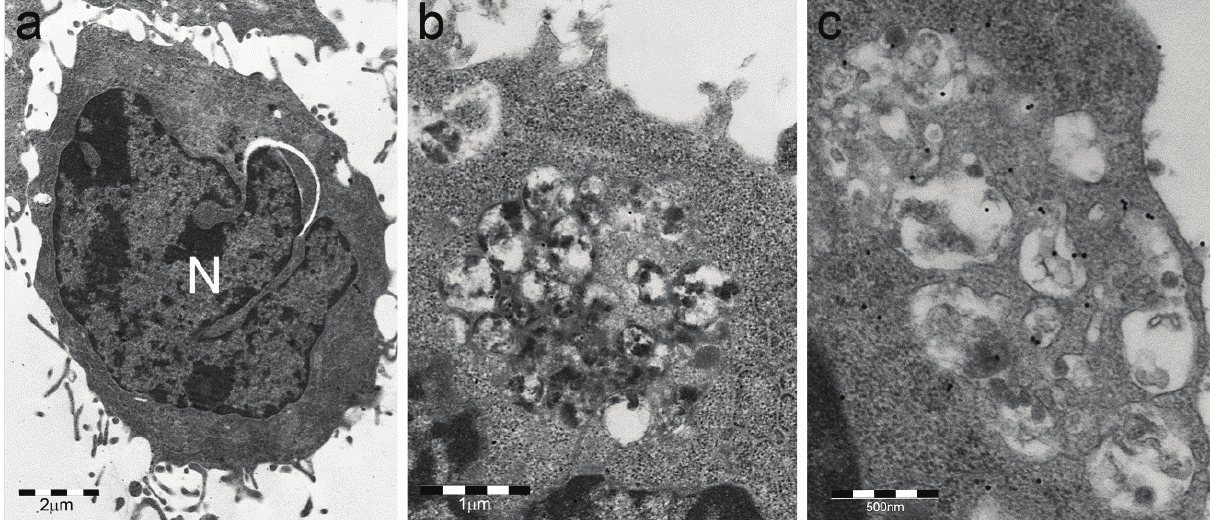
Figure 3. Cytoplasmic bodies of RAW 264.7 macrophage observed by electron microscopy (see [15] for technical details). ( a ) Untreated cell. N, nucleus; ( b , c ) LPS-treated cells show large, p62-immunoreactive aggregates of vesicles and enveloping membranes partly filled with amorphous electron-dense material. These structures ultrastructurally and cytochemically resemble the DALIS and endosome-mediated autophagic structures described by Kondylis et al. [14] in LPS-treated DCs. They are likely to be the same as the proteasome unreactive, andp62, FK2 and LAMP1 reactive bodies of Figure 2, considering that no sequestosome was found by TEM in LPS-treated RAW 264.7